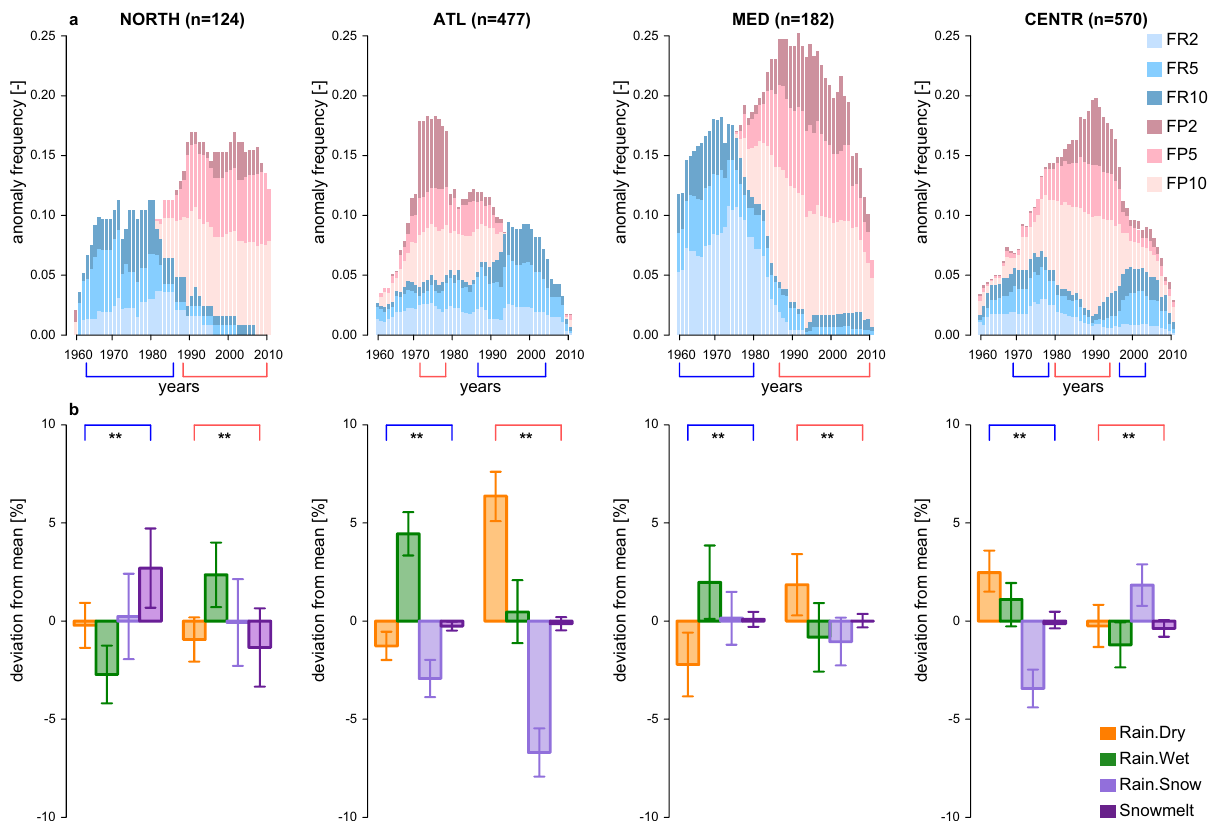
Fig. 4 Regional fl ood anomalies and shifts in fl ood generation processes in four European regions. a Regionally aggregated fl ood-rich and fl ood-poor periods. The height of bars corresponds to the portion of catchments where at least one fl ood-rich (blue colours) or fl ood-poor (red colours) anomaly was detected. Flood-rich anomalies are plotted in front of fl ood-poor anomalies (see Supplementary Fig. 9a for a stacked version). Proportions of anomalies with different return periods (2, 5 and 10 years) are indicated correspondingly FR2, FR5 and FR10 (shades of blue) for fl ood-rich periods and FP2, FP5 and FP10 (shades of red) for fl ood-poor periods. b Deviations of frequencies of fl ood generation processes during periods with opposing prevailing anomalies (corresponding to the blue and red time windows indicated on the bottom of the panel a, see also Methods and Supplementary Note 5 for the sensitivity analysis of the de fi nition of these time windows on the test results) compared to the mean composition of the whole study period in all catchments. Error bars show con fi dence intervals of differences for each fl ood generation process for a signi fi cance level of α = 0.05. The signi fi cance of these differences is evaluated using a χ 2 test with false discovery rate correction among regions (** indicates signi fi cant differences with α = 0.05 of false discovery rate correction; exact p-values for each individual χ 2 test are provided in Supplementary Table 2) for each period with opposing prevailing anomalies indicated by the blue and red time